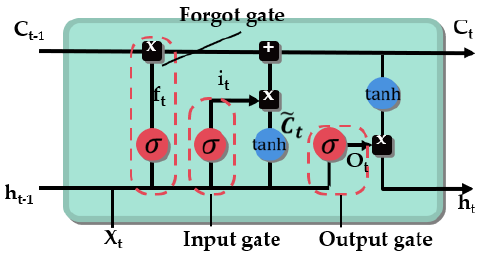
Figure 2. Self-circulating structure in LSTM where x t is the current input; h t−1 is the output at the previous moment; h t is the current output; C t − 1 is the previous cell state; C t is the current cell state; f t is the forget gate neuron in LSTM The output of the cell; i t is the output of the input gate neuron in LSTM; (cid:101) C t is the new candidate values for cell status; O t is the output of the output gate neuron in LSTM; σ is the sigmoid activation function and tanh is the tanh activation function.